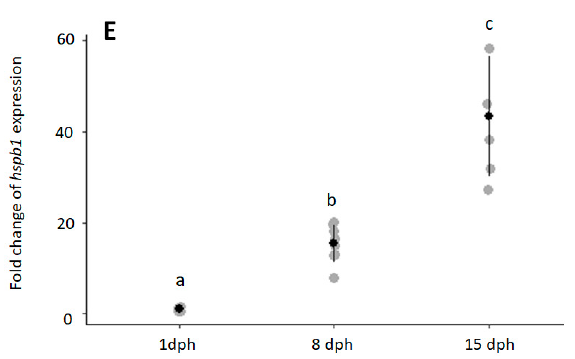
Figure 2. Temporal expression in European eel larvae at 1 ( n = 10), 8 ( n = 8) and 15 ( n = 6) dph of ( A ) major-histocompability complex class I mhc1 ( p > 0.2295); ( B ) M-protein myom2 ( p < 0.0019); ( C ) dopamine 2B receptor d2br ( p < 6.12 × 10 − 5 ); ( D ) melatonin receptor mtr1 ( p < 8.75 × 10 − 5 ); ( E ) heat-shock protein beta-1 hspb1 ( p < 6.12 × 10 − 5 ). Outliers (>2 Standard Deviation—SD) were detected at 1 dph for d2br and hspb1 and at 8 dph for myom2 , which were removed before running the statistical analysis. Expression is shown as fold change vs. 1 dph larvae. Individual values are given in grey, averages with standard deviation in black. Different letters (a, b, c) indicate statistical differences between groups (Kruskal–Wallis followed by a pairwise Wilcoxon-test, p < 0.05).